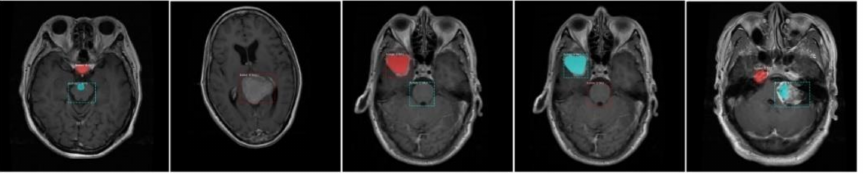
Figure 10. Example of inaccurately localized brain tumor images by the proposed method. The red and blue contour shows the predicted tumor region and respective